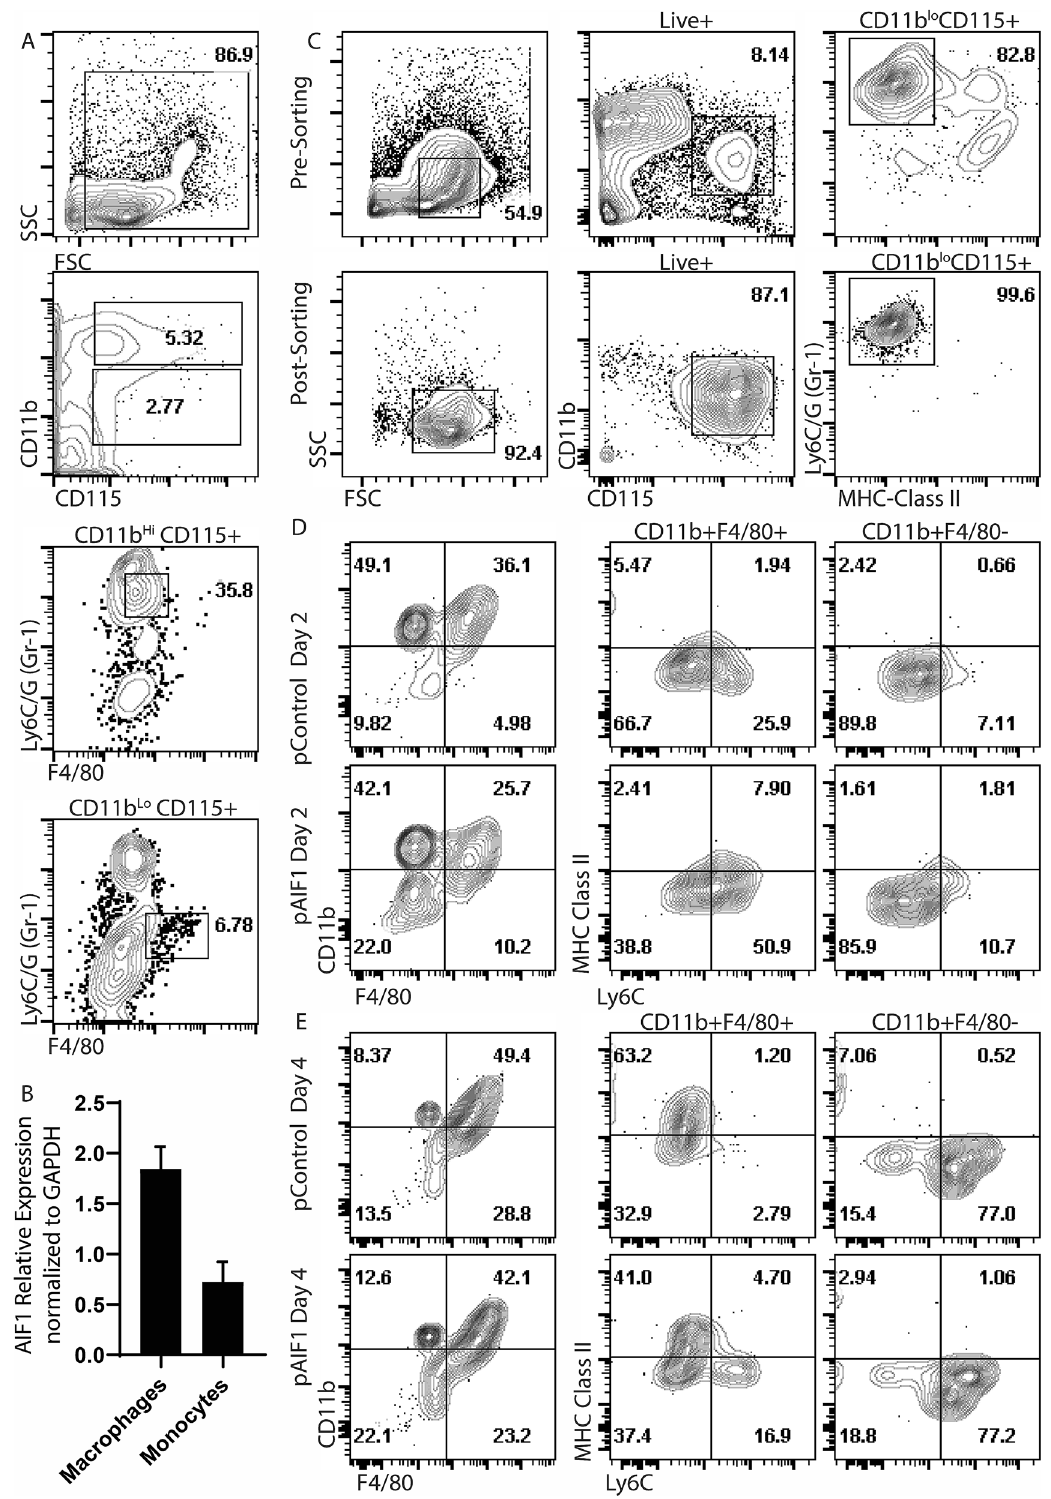
Figure 5. Ly6C + sorted monocytes require AIF1 to differentiate into macrophages. ( A ) CD11b hi CD115 + Ly6C/ G + F4/80 neg monocytes and CD11b lo CD115 + Ly6C/G neg F4/80 + macrophages were flow cytometric sorted from the spleen of wild type C57BL/6 mice ( n = 3). ( B ) AIF1 gene expression was then assessed by real-time PCR in the monocytes versus macrophage populations. ( C ) Bone marrow cells isolated from C57BL/6 ( n = 6) are shown prior to (pre-sorting) and after sorting (post-sorting) to purify CD11b low CD115 + Ly6C/G + F4/80 neg monocytes. ( D ) Isolated CD11b low CD115 + Ly6C/G + F4/80 neg monocytes were then immediately silenced for AIF1 prior to culturing with M-CSF. After ( D ) 2 days and ( E ) 4 days of M-CSF stimulation, cells were assessed for Ly6C and MHC class II expression within the CD11b + F4/80 + and CD11b + F4/80 neg populations. Data shown as mean ± SEM and representative of three independent experiments. Statistical significance was determined by unpaired t -test. * p < 0.05 and ** p <